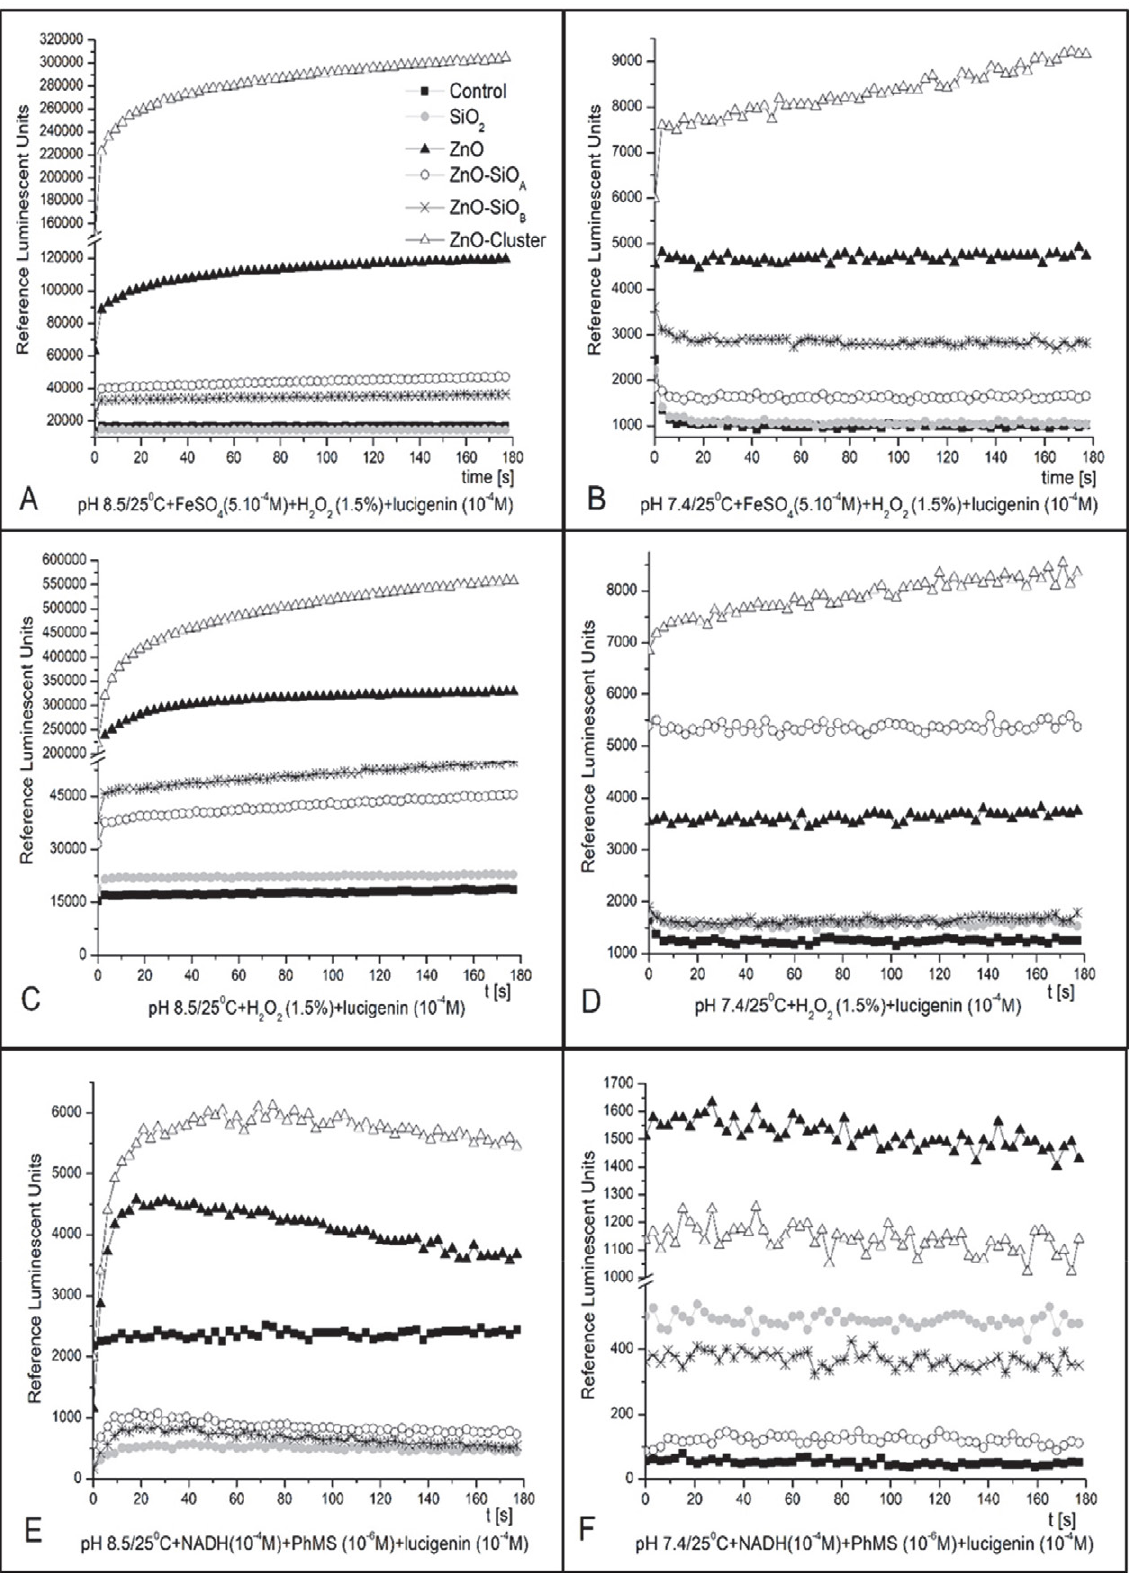
Figure 3. Chemiluminescence induced in the Fenton`s system (system I: A, B), by H 2 O 2 (system II: C, D) and O 2– radicals (system III: E, F) in sec- onds, at pH 8.5 and 7.4 in the presence/absence of